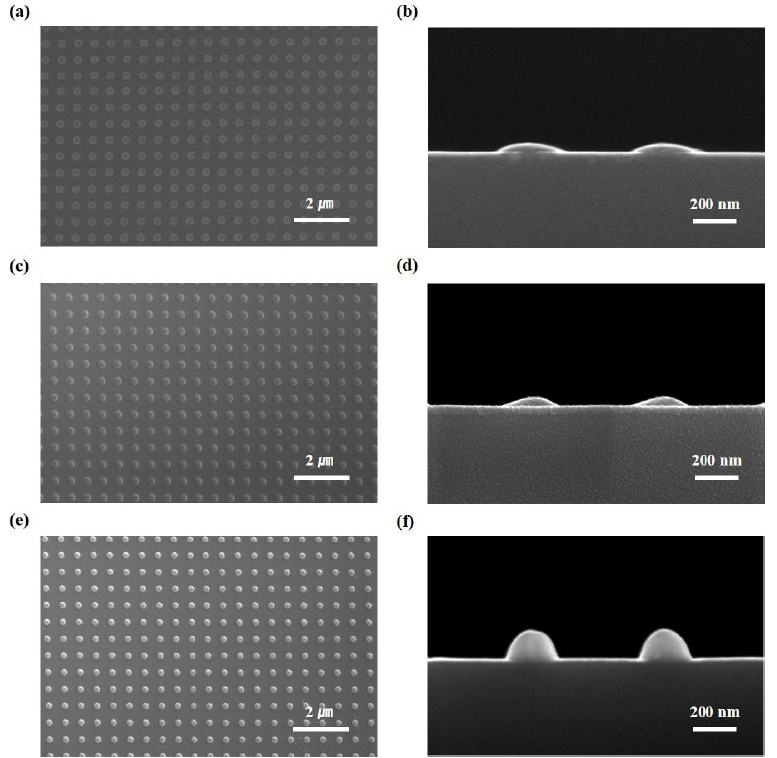
Figure 4. Fabricated convex nanostructures after transfer to the Si substrate by the MPDMS bonding, swelling (i.e., no swelling or full swelling), and breaking process (used as a hard mask against dry etching): ( a , b ) are SEM images of the top and cross-sectional views, respectively, of transferred convex patterns (diameter of 300 nm, spacing of 300 nm, and height of 40 nm) onto the Si substrate by the bonding and breaking process (no swelling). ( c , d ) are SEM images of the top and cross-sectional views of fully swelled and transferred convex patterns, respectively. ( e , f ) present convex Si nanostructures formed by deep reactive ion etching (RIE) through the MPDMS hard masks with convex patterns as shown in ( c , d ).